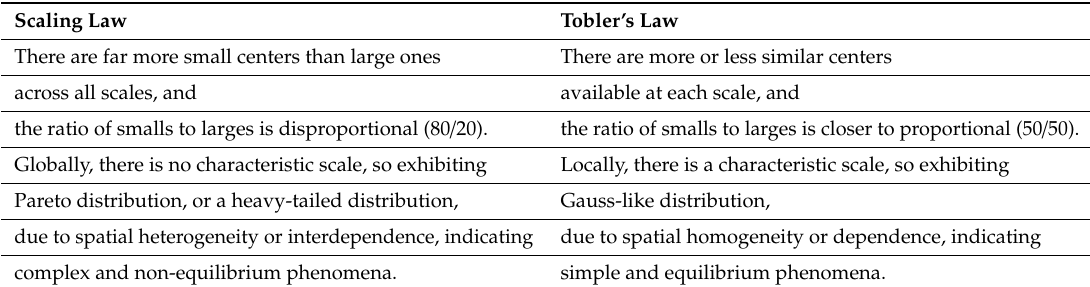
Table 1. Two fundamental laws of living structure. (Note: These two laws—scaling law and Tobler’s law—complement each other and recur at di ff erent levels of scale of living structure). Scaling Law Tobler’s